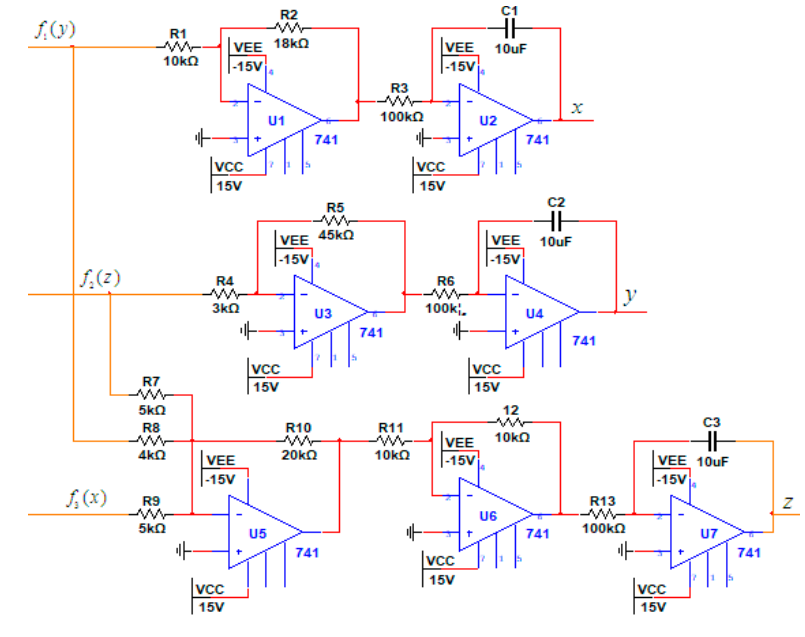
Figure 12. The implement circuit of system (2).